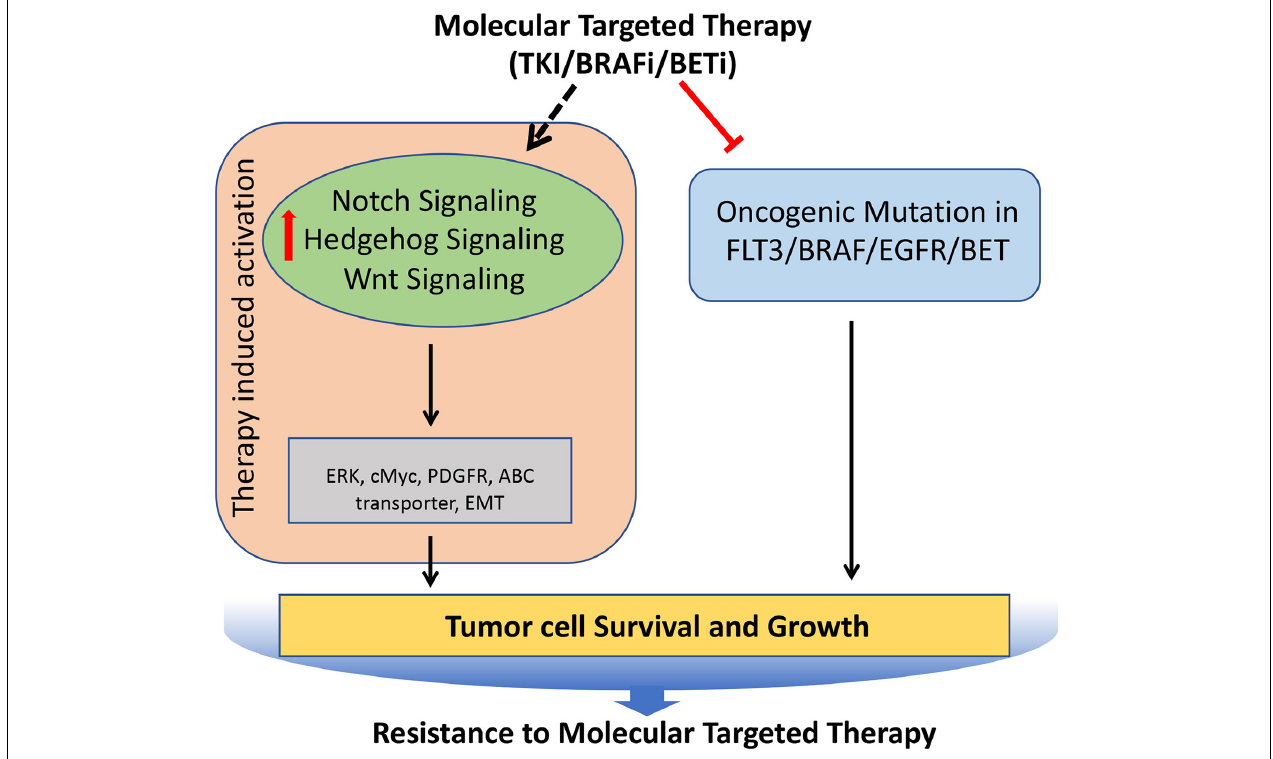
FIGURE 6 | Role of Notch, Hedgehog, and Wnt signaling pathways involved in the acquisition of resistance to molecular targeted therapies in tumors. Molecular targeted therapies block the oncogenic mutated molecular targets in cancer, but often it leads to induced hyperactivation of Notch, Hedgehog, and Wnt signaling pathways, which regulates key molecules (such as cMyc, PDGFR, ERK etc.) involved in the tumor cell survival and growth, resulting in the development of resistance against molecular targeted therapies. TABLE 2 | Overview of the clinical trials evaluating drugs targeting developmental signaling pathways. Pathway Neoplasms included Targets Mono-therapy Combined therapies Trial stage